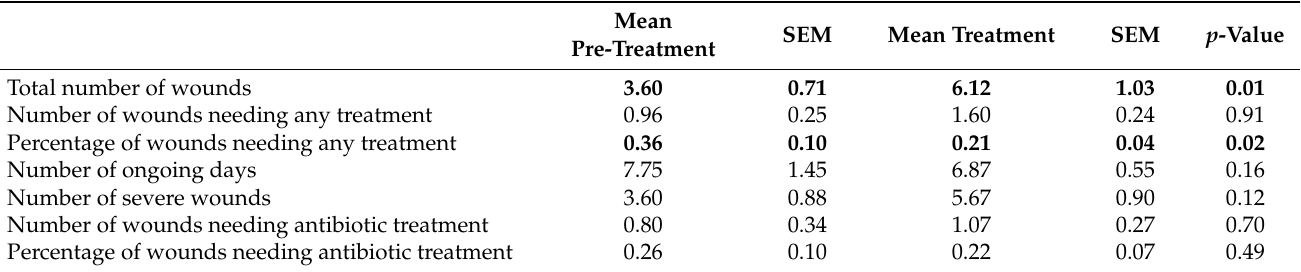
Table 2. Descriptive statistics for each wounding variable (per animal) and significance level for each pre-treatment vs. treatment period